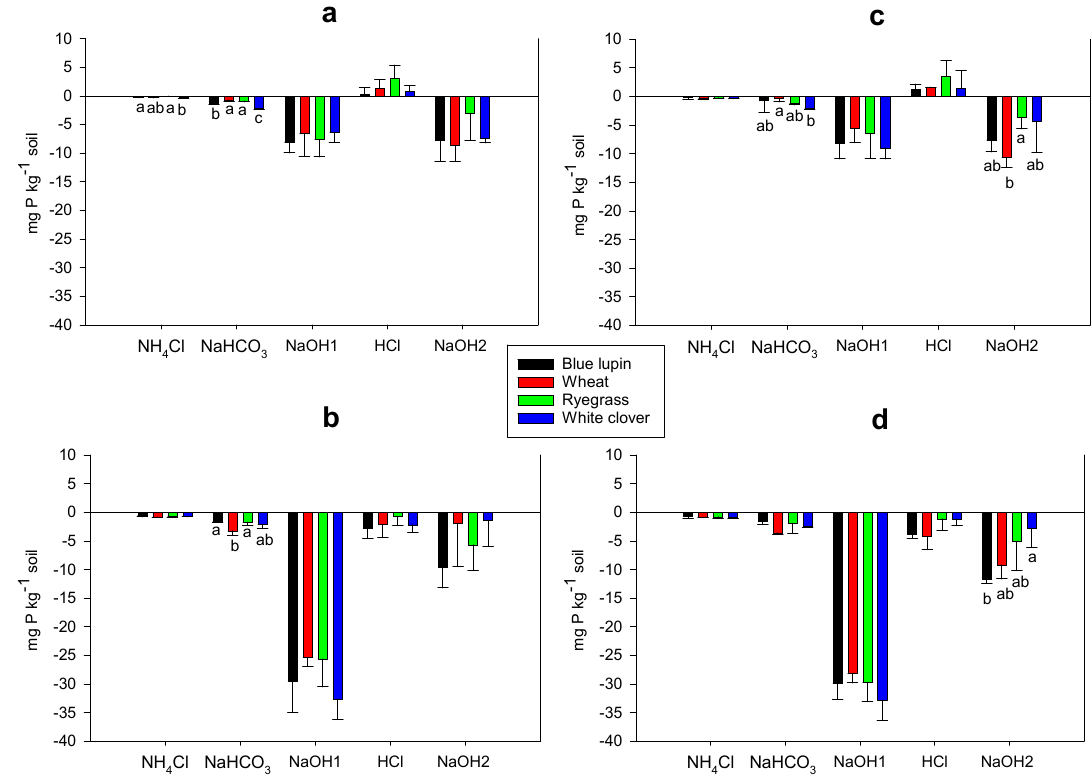
Figure 4. Changes (depletion or accumulation) in different inorganic P fractions with the control conditions ( a ), P treatment ( b ), N treatment ( c ), and NP treatment ( d ) in the rhizospheres of blue lupin, wheat, ryegrass, and white clover. Different letters denote a significant difference ( p < 0.05) among plant species for a given nutrient treatment.